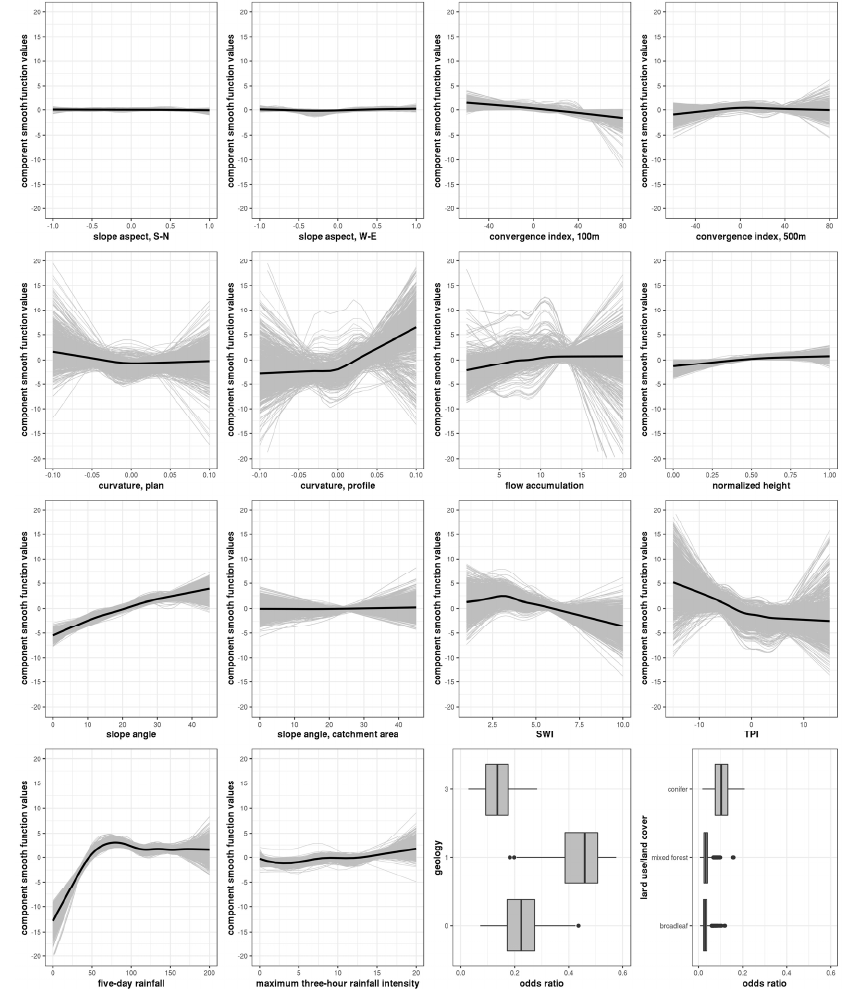
Figure A4. Component smooth function plots for GAM-Co; Geological units: Reference: Neogene formations with coarse-grained layers, 0: other units, 1: Neogene formations dominated by fine- grained sediments, and 3: pre-Würmian Pleistocene formations; LULC classes: Reference: no forest.